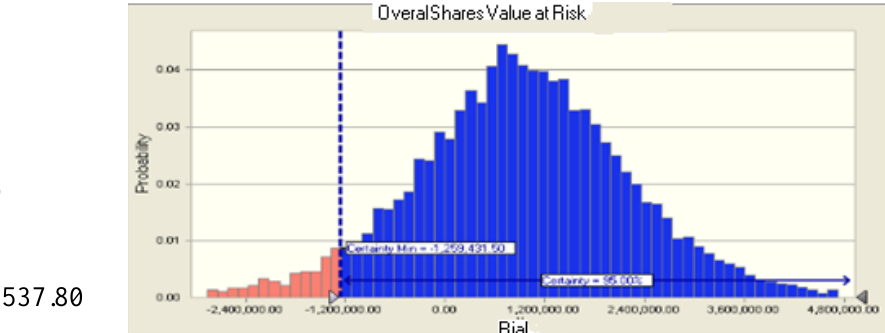
Fig. 1. Frequency Figure of Crystal Ball Software to Portfolio VaR Measurement